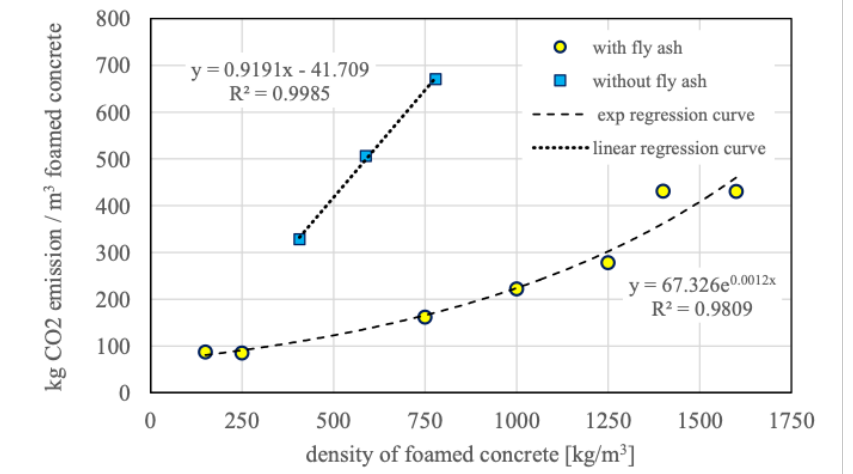
Figure 4. Increase of CO 2 emission for foamed concrete with and without fly ash in the mix design as a function of the